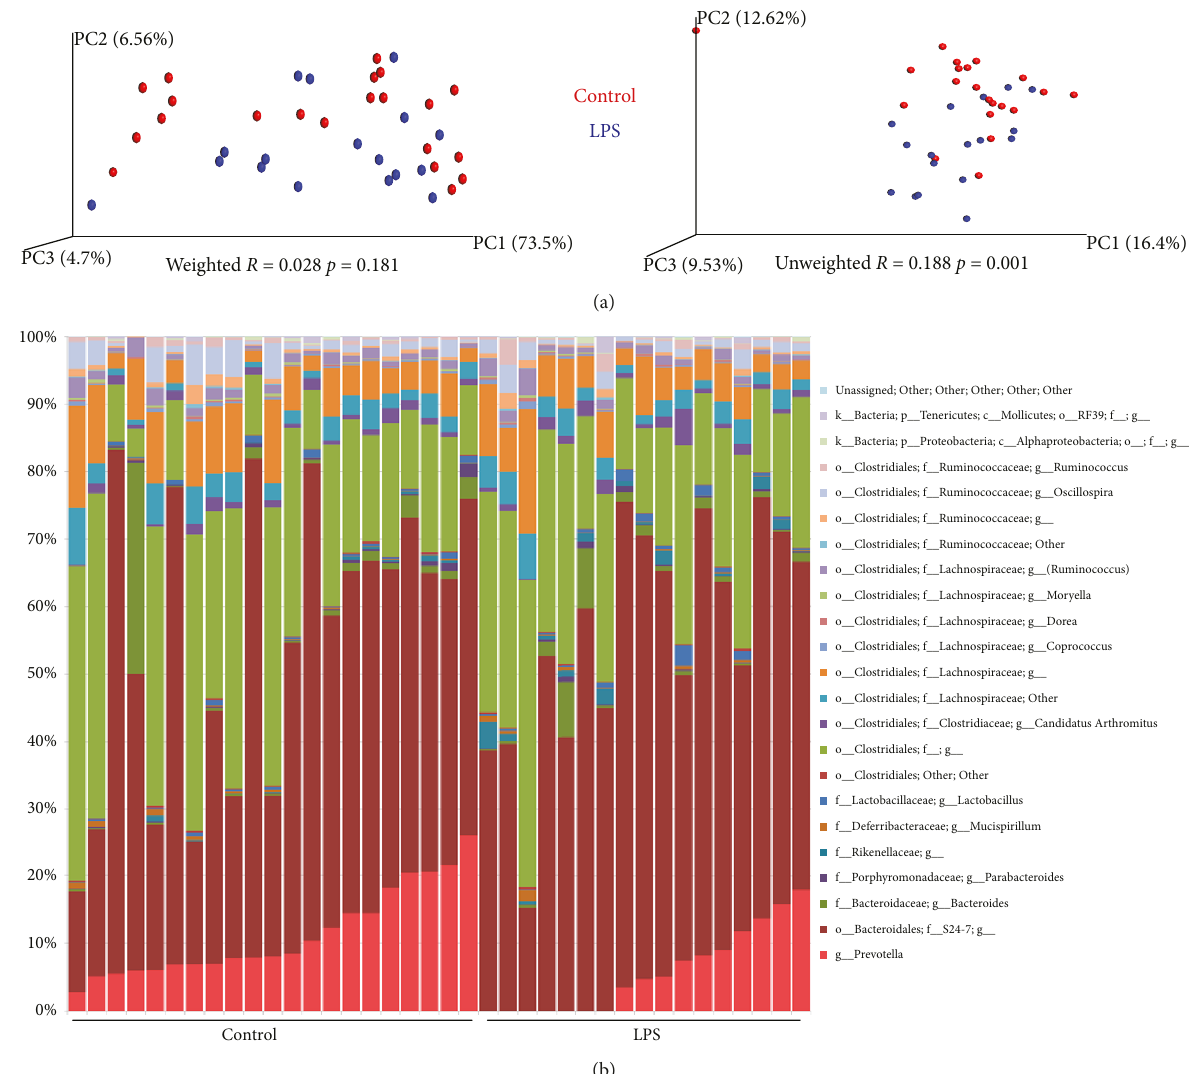
Figure 4: Weighted and unweighted principal component analysis plots showing microbiota clustering (a) and bar chart demonstrating relative abundances of genera (b) after 16S sequencing of feces of 40 (18 female and 22 male) four-week-old C57BL/6NTac mice given either LPS ( n = 18 ) or PBS ( n = 22 ) orally daily from birth until weaning at four weeks of